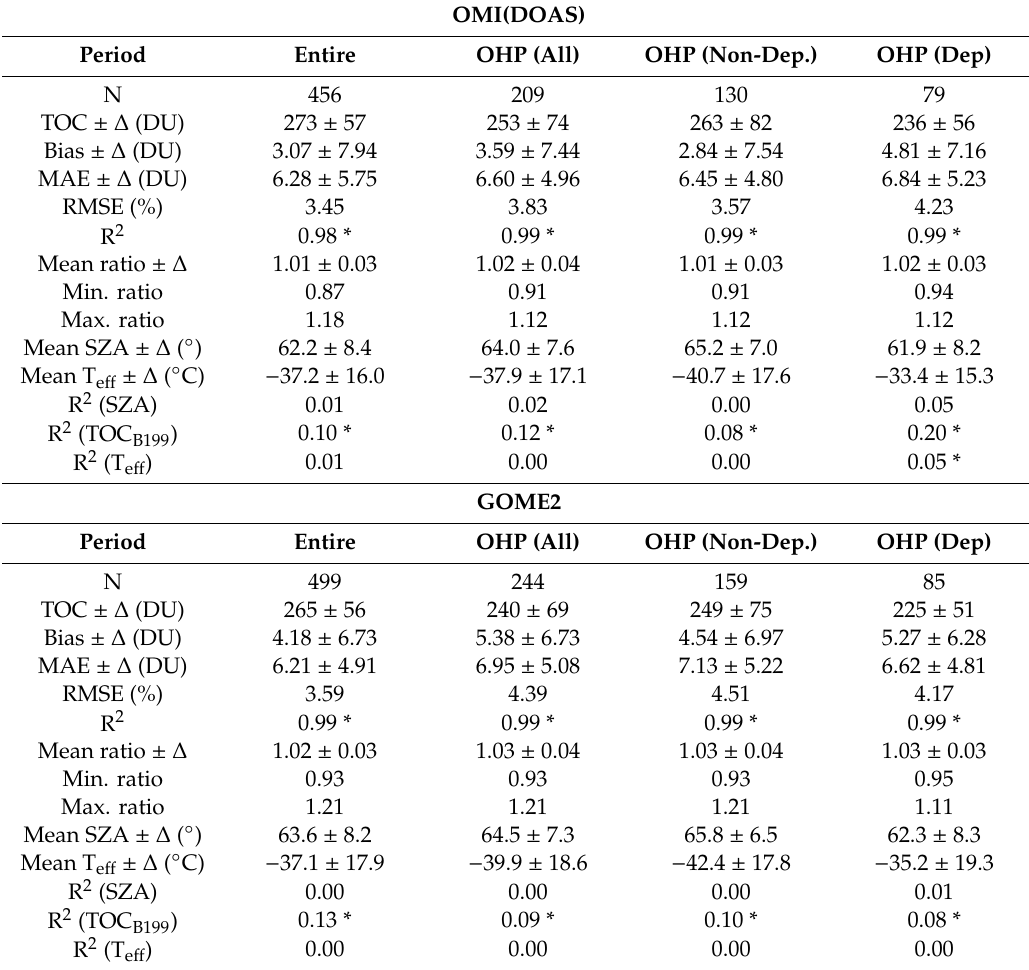
Table A2. Statistical characteristics calculated for individual data sources (asterisks indicate statistically significant ( α = 0.05) correlations).